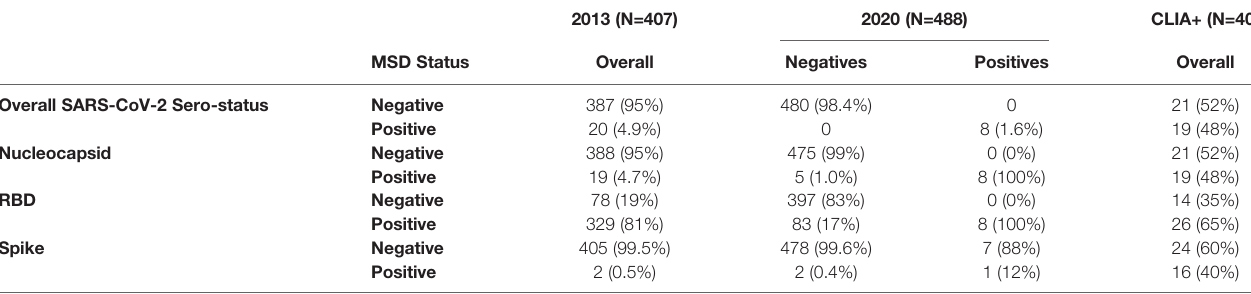
TABLE 2 | Population above positivity cut-off for SARS-CoV-2 targets in 2013 and 2020.